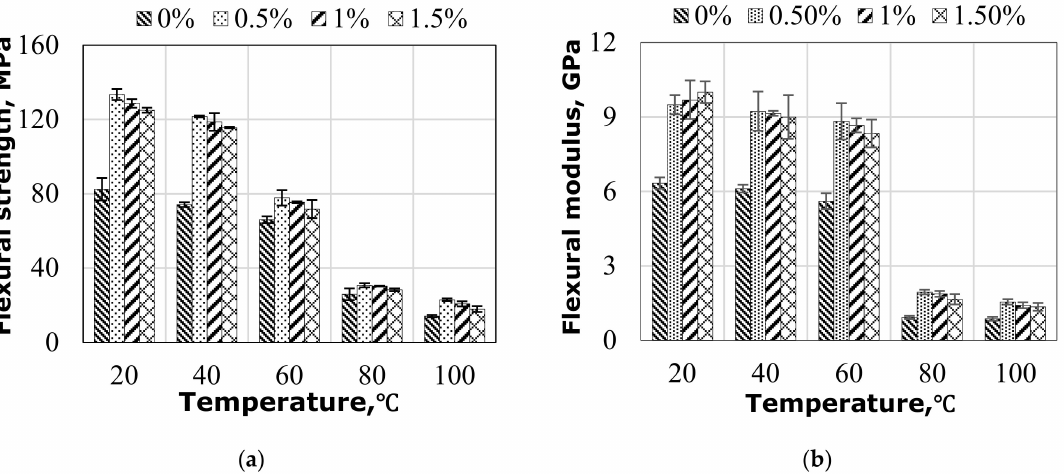
Figure 3. Temperature influence on the flexural properties of hybrid composites: ( a ) Flexural strength; ( b ) flexural